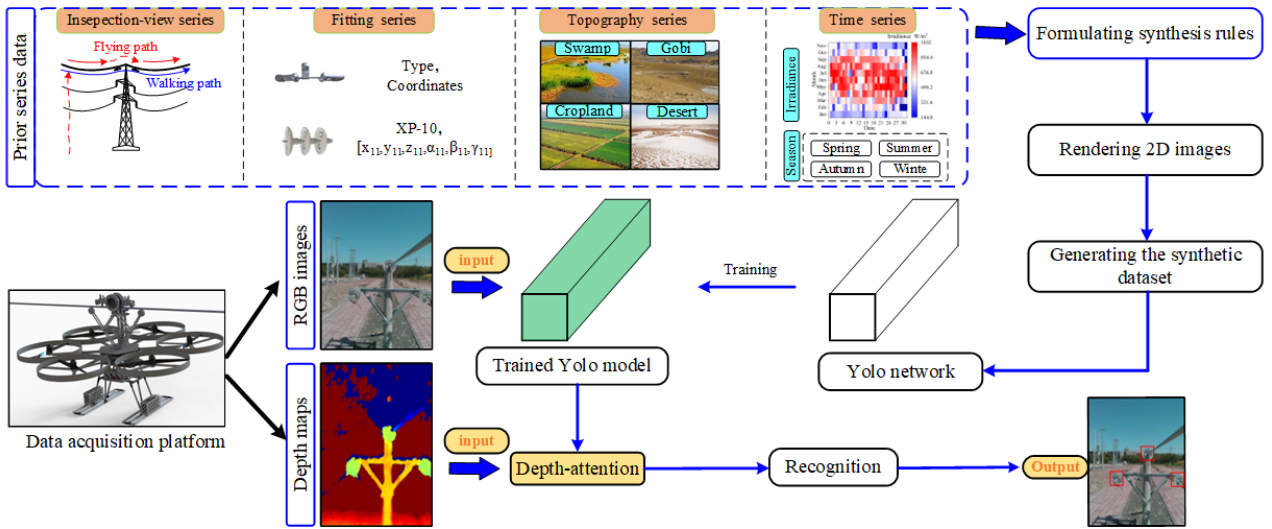
Figure 6. Diagram of the fitting recognition